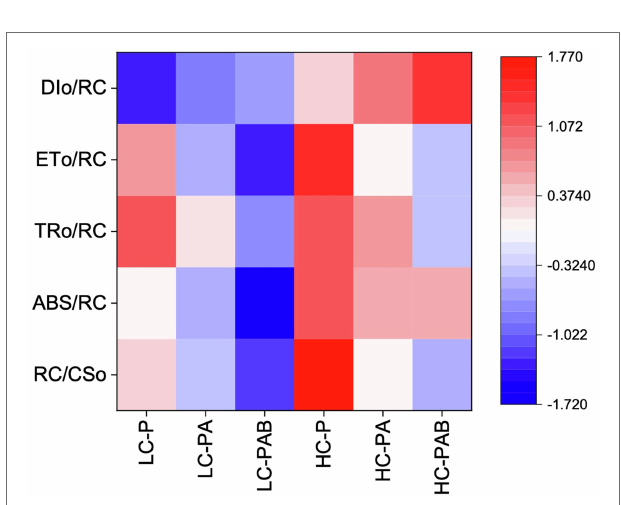
FIGURE 6 | Variations in the density of the PSII reaction centers per excited cross section (RC/CSo) and the specific energy fluxes [the absorbed flux (ABS/RC), the trapping flux (TRo/RC), the electron transport flux (ETo/RC), and the dissipated energy flux (DIo/RC)] of P. yezoensis growing for 9 days. LC and HC stand for low (~400 μ atm) and high (~1000 μ atm) CO 2 conditions, respectively. P, PA, and PAB stand for PAR only, PAR + UVA, and PAR + UVA + UVB, respectively.